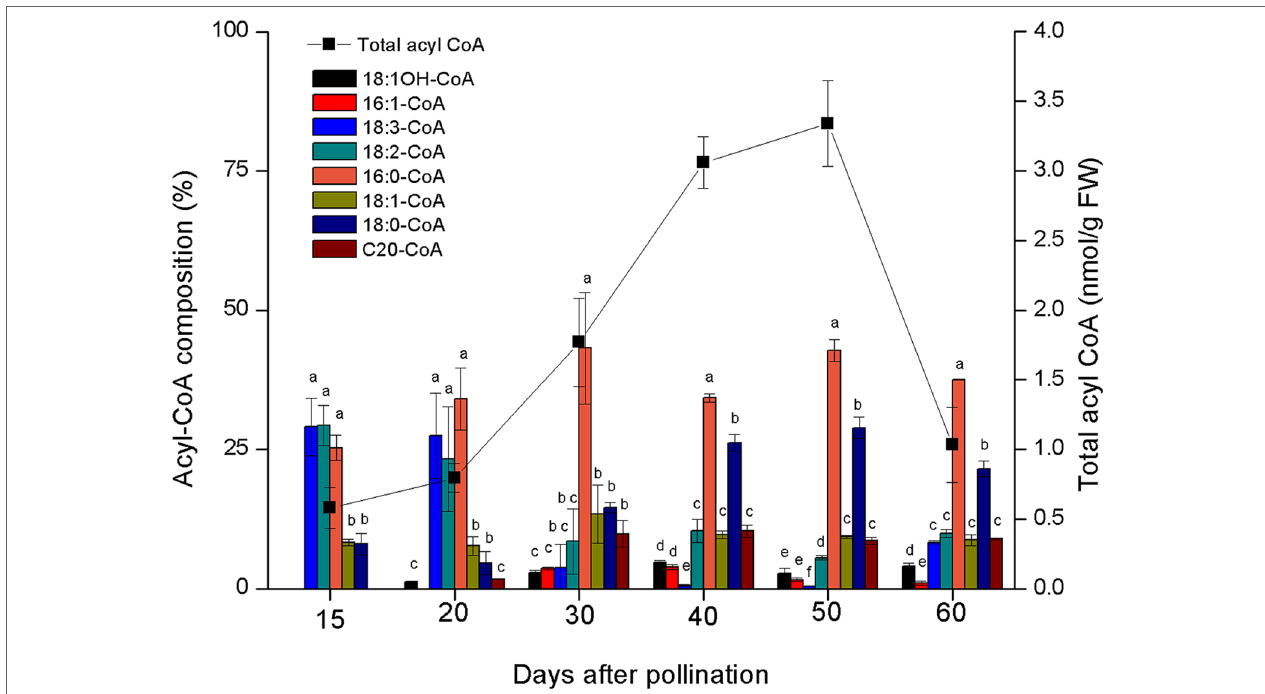
FIGURE 6 | Composition and size of the castor acyl-CoA pool during seed development. The data are the average of three to four independent determinations. The data are the average ± SD of 4 independent determinations. Letters indicate statistically significant differences (one-way ANOVA 0.05% significance level) when comparing acyl-CoAs at same days after anthesis